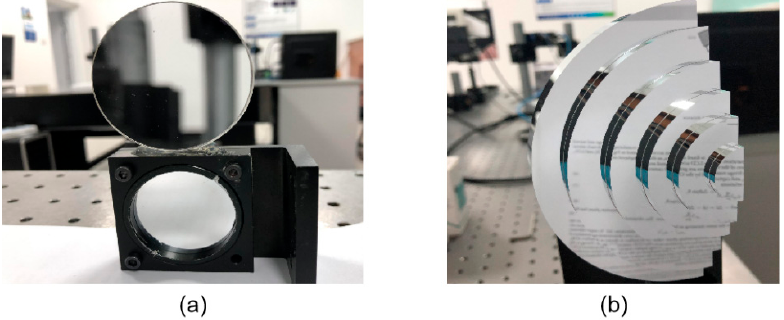
Figure 9. Photos of the measured specular objects. ( a ) Two separate specular objects; ( b ) Discontinuous fan-shaped mirror step. Table 3. Comparison results of the fan-shaped mirror step by using IR light and visible light (units: mm).